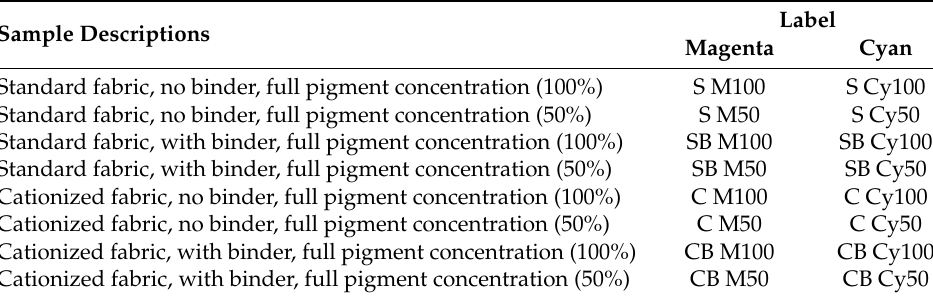
( b ) Figure 5. The K/S values of printed samples before washing. ( a ) Magenta and ( b ) Cyan pigment. Tables 9 and 10 show the objective values of lightness (L*), chroma (C*) and hue (h*) of the measured samples. For the purpose of comparing the values of the colour parame- ters, the tables comparatively show the results for the non-cationized (labelled S) and cat- ionized (labelled C) samples. In general, it can be seen from the results that the specific ratio of lightness and chroma, from which the colour intensity arises, depends on the in- teraction of the amount of pigment applied and the characteristics (pre-treatment) of the fabric. Table 9. Objective values of colour parameters lightness (L*), chroma (C*) and hue (h°) for samples printed with magenta pigment.